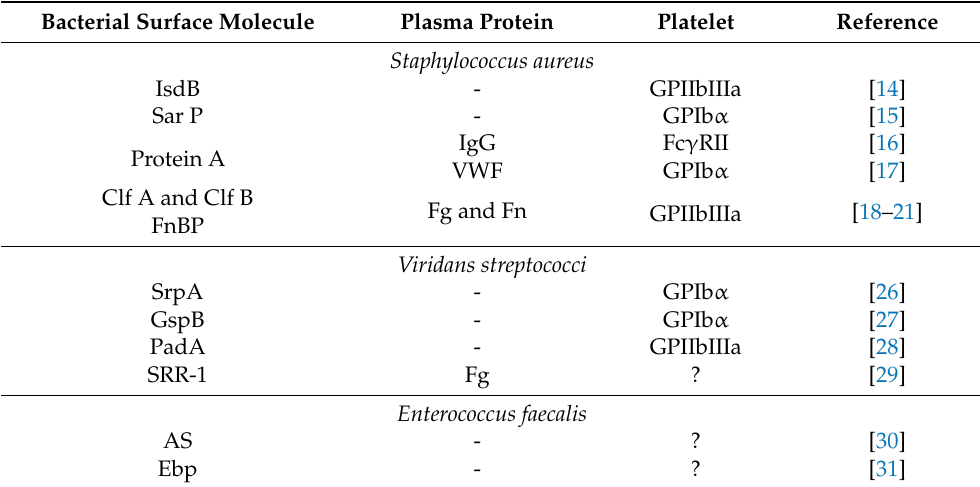
Table 1. Involvement of bacterial membrane surface molecules in platelet activation. Bacterial Surface Molecule Plasma Protein Platelet